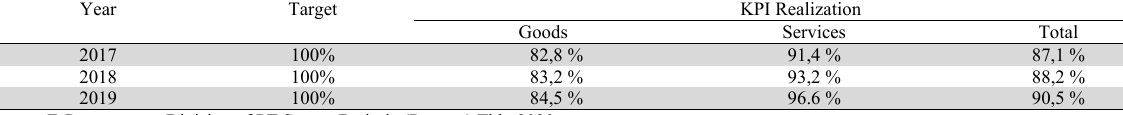
Realization of KPI Procurement of PT Semen Baturaja (Persero)